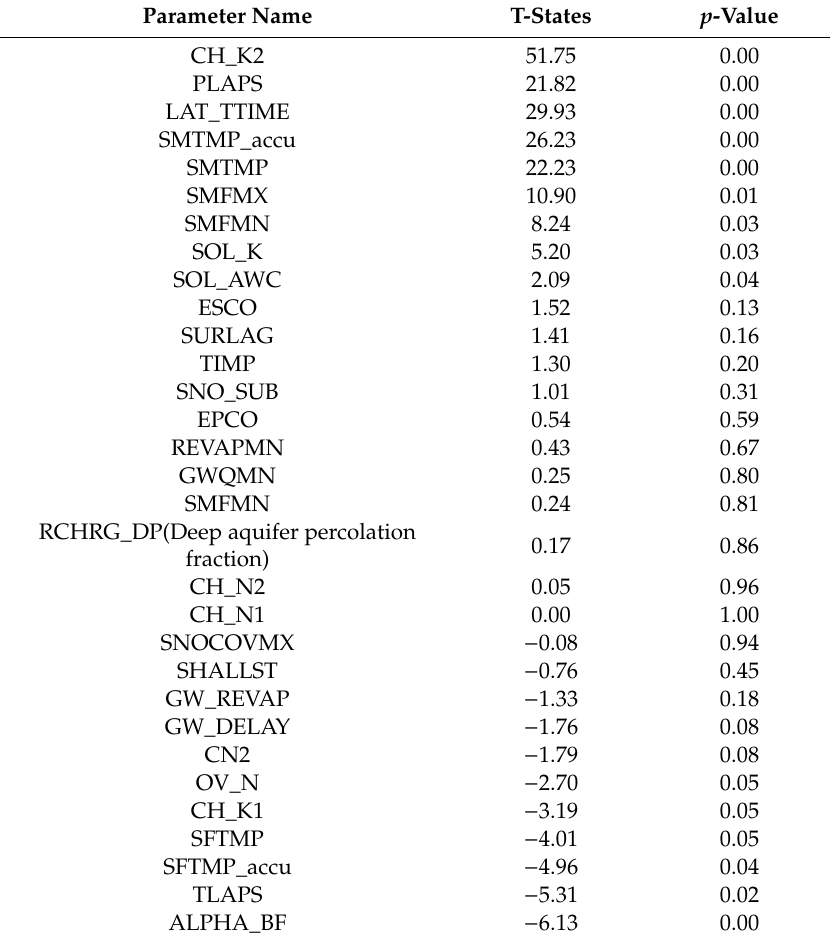
Table 2. The parameter information for global